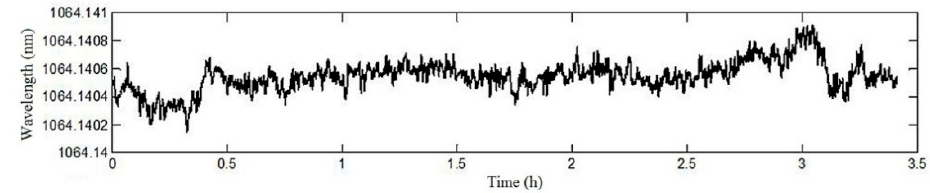
Figure 6. Calibration of the wavelength of one interferometer.